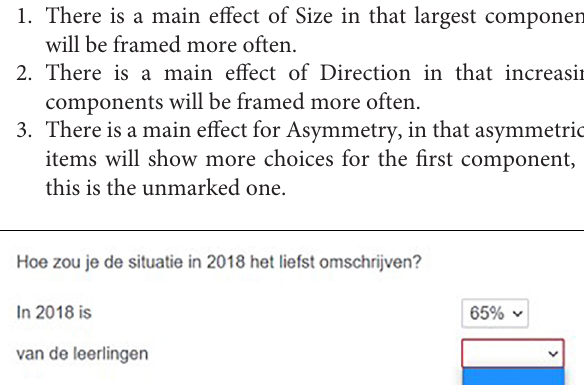
Frontiers in Psychology |